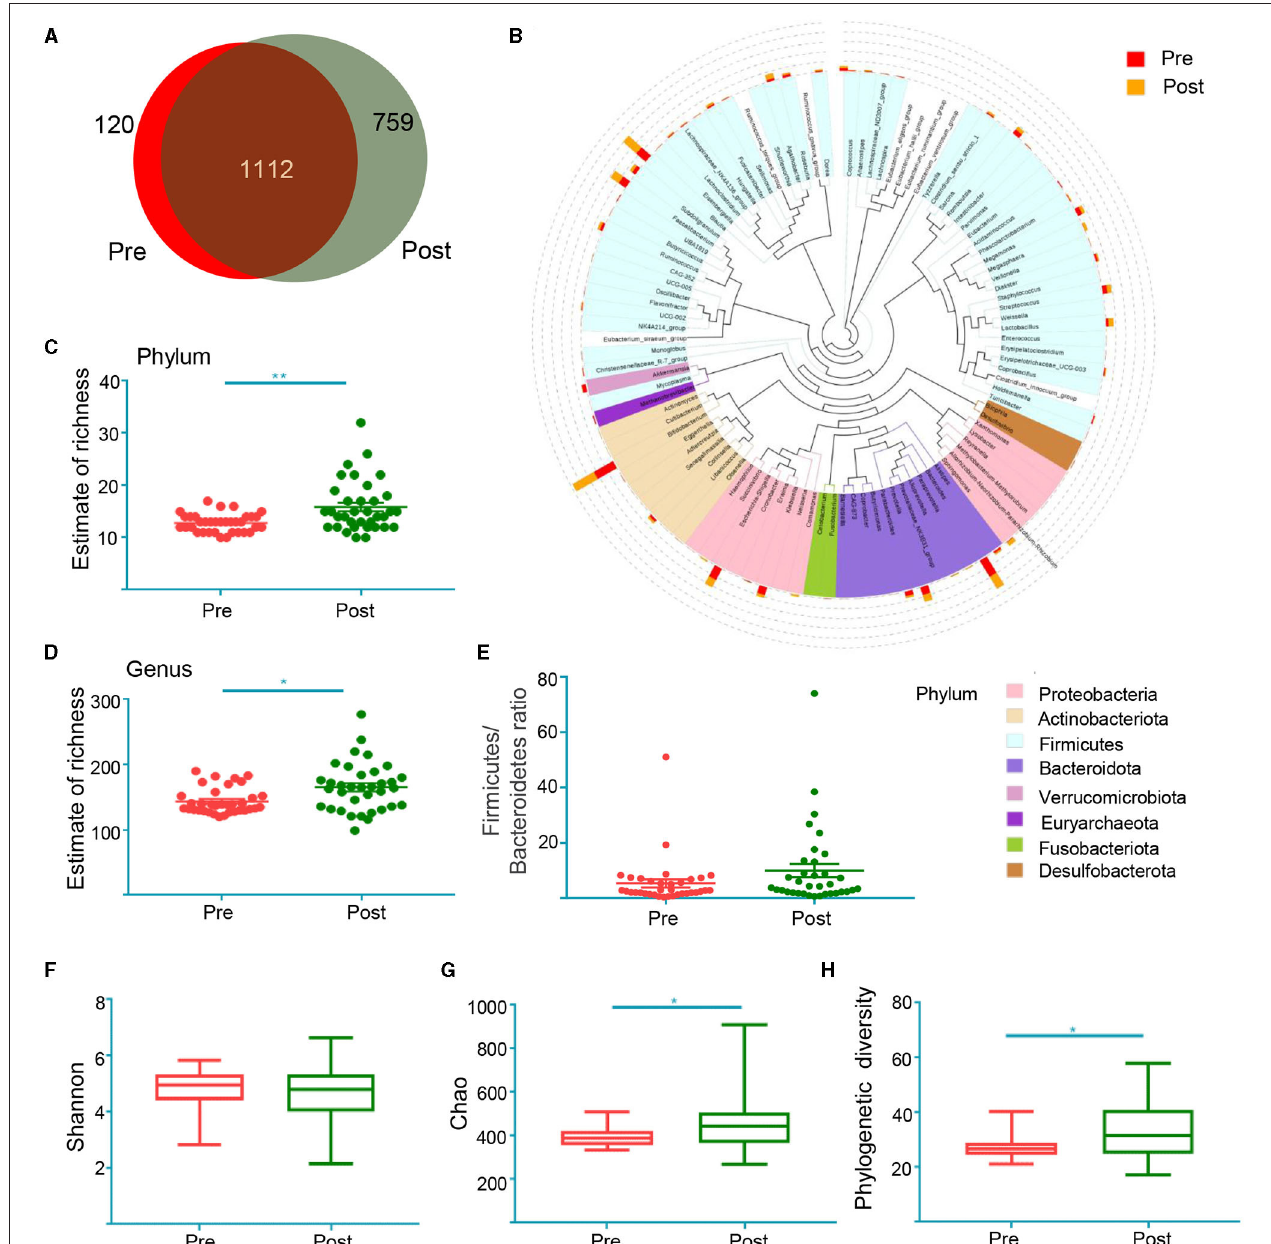
FIGURE 3 | The shift of gut microbiota in the patients before treatment (Pre) and after treatment (Post) according to the 16S rRNA data. (A) Venn diagram of the observed OTUs in Pre and Post; (B) the representative sequences of Top 100 were obtained by multi-sequence alignment. The colors of branching and fan represent the corresponding phylum, and the stacking bars outside of the fan ring indicate the abundance distribution information of the genus in different samples; the estimate of richness index analysis between two groups at the level of Phylum (C) and genus (D) . * p < 0.05, ** p < 0.01, Mann Whitney test; Firmicutes–Bacteroidetes ratio at the phylum level (E) . Alpha diversity indices of Shannon index (F) , Chao index (G) and phylogenetic diversity index (H) . * p < 0.05, ** p < 0.01, Wilcoxon rank-sum